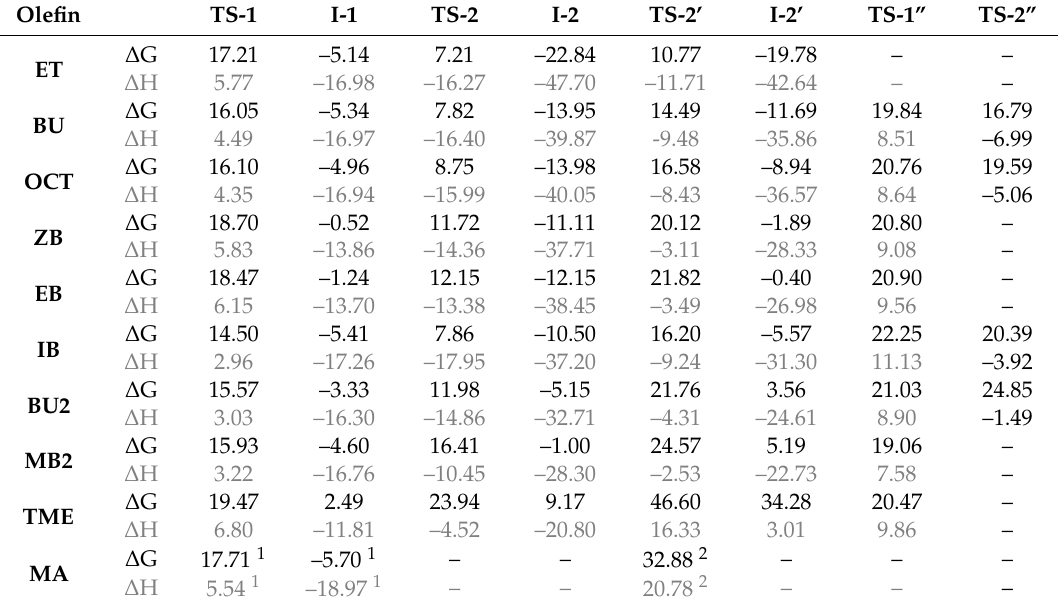
Table 2. Calculated free energies and free enthalpies of the key intermediated and transition states for MA–olefin